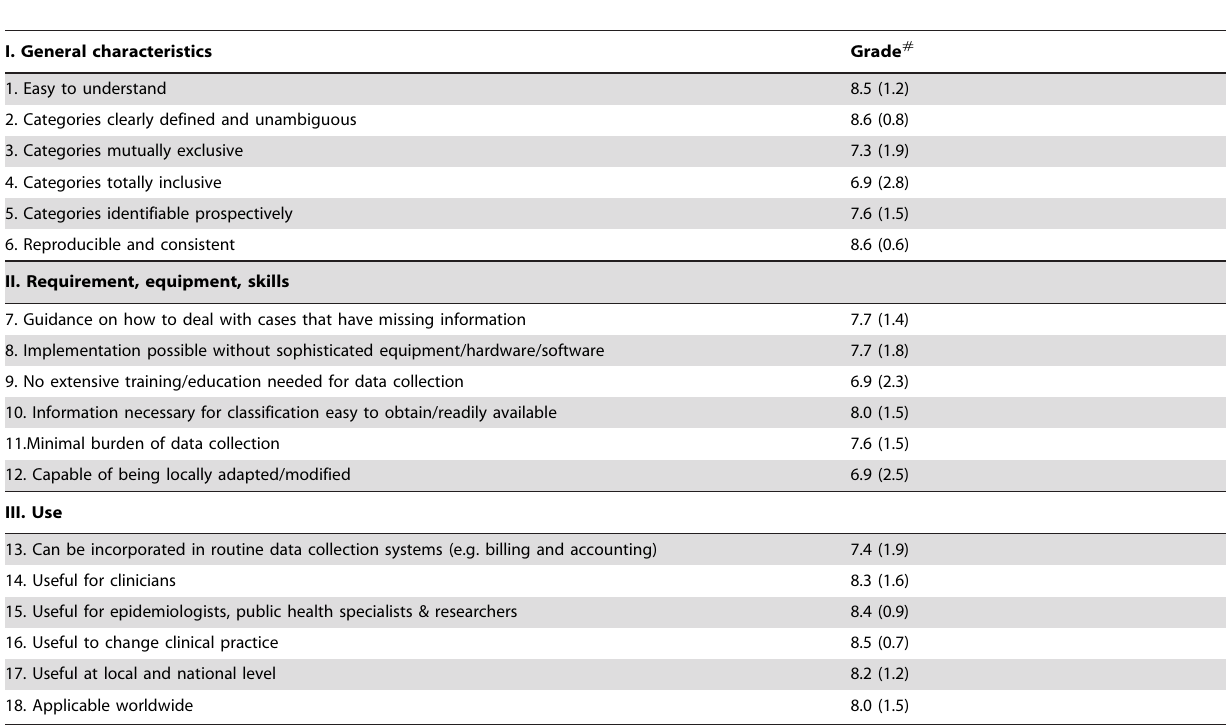
Table 1. Questionnaire on characteristics of classifications for caesarean sections: grade given by